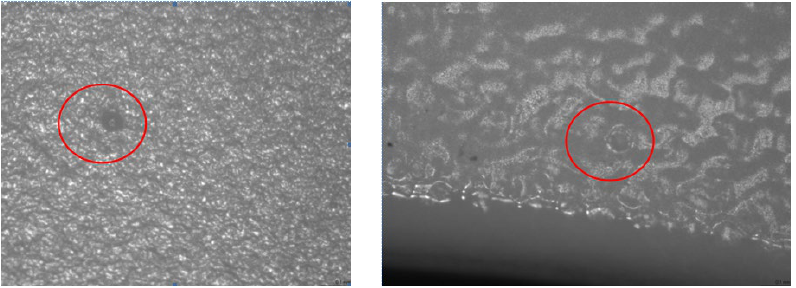
Figure 15. Optical microscopy inspection of the parts resulted using an increased mold tempera-